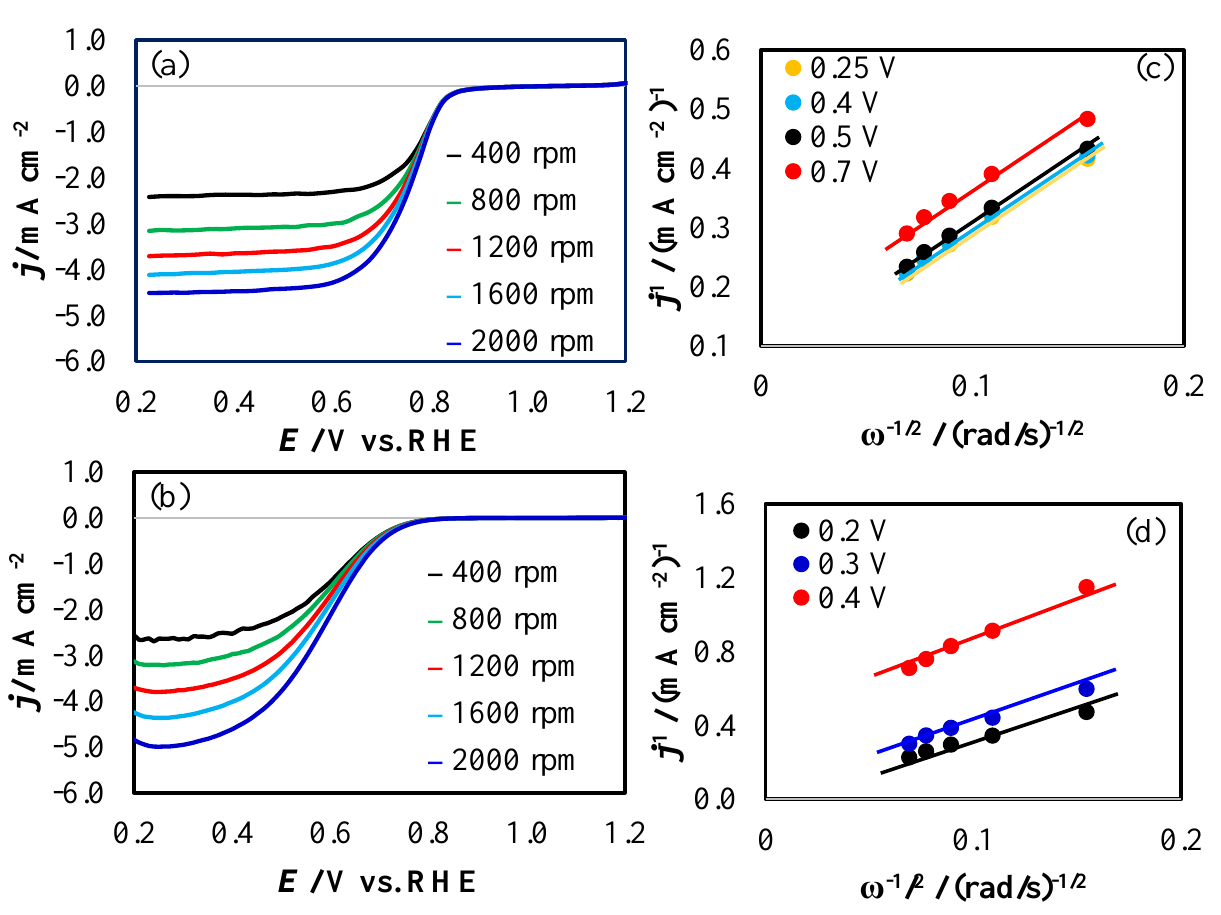
Figure 4. Hydrodynamic voltammograms obtained at the disk electrodes coated with (a) state-of-the-art Pt/C catalyst and (b) Pt/Ti 9 O 17 catalysts in O 2 -saturated 0.5 M H 2 SO 4 solution at scan rate of 10 mV s − 1 at various rotation rates of 400 to 2000 rpm. Koutecky–Levich plots at various potentials obtained with (c) state-of-the-art Pt/C catalyst and (d) Pt/Ti 9 O 17 As shown in Figure 4c,d, the Kouteckey–Levich plots of i l − 1 versus ω − 1/2 at various potentials for the voltammograms of Figure 4a,b gave the straight lines the slopes that are equal to that expected for four-electron ORR, and the values of n were found to be 3.98 and 3.94 for the Pt/C, and Pt/Ti 9 O 17 electrocatalysts,